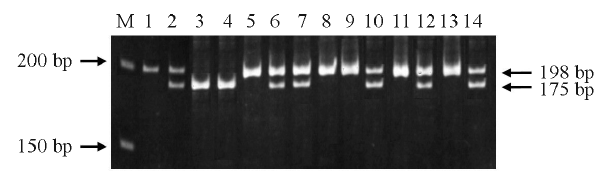
Figure 1 - Polymorphism analysis of the methylenetetrahydrofolate reductase (MTHFR) 677C (cid:1) T allele: Hinf I-digested PCR fragments from the 677C (cid:1) T polymorphism (175 bp) and from the normal allele (198 bp). M = molecular weight markers; 1 = undigested control frag- ment; 2 = 677C (cid:1) T heterozygous control: 3 and 4 = 677C (cid:1) T homozy- gous Turner syndrome (TS) individuals; 5, 8, 9, 11 and 13 = 677C (cid:1) T null TS individuals without the polymorphism; 6, 7, 10, 12 and 14 = 677C (cid:1) T heterozygous TS